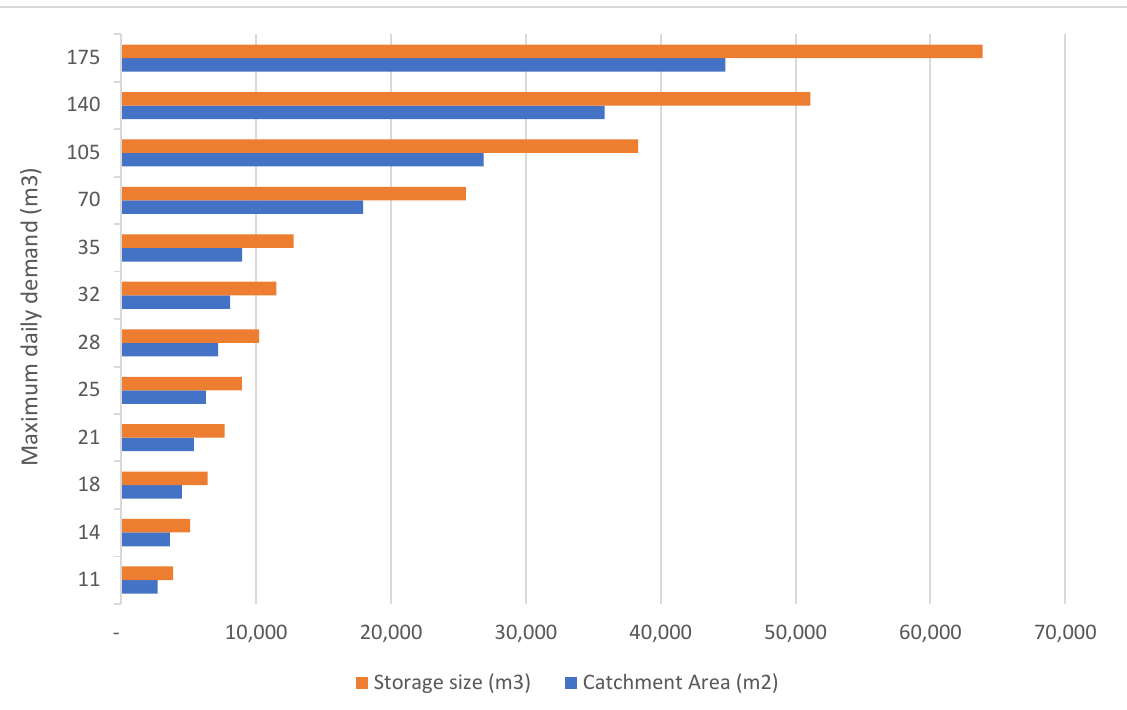
Figure 10. Illustration of water demand and resulting maximum catchment (m 2 ) and storage (m 3 ) sizes for securing the demand from unpaved surfaces. For the illustrated capacities, it is recommended that, instead of having a single large storage facility, there should be a series of smaller-sized storage facilities, storing water 0